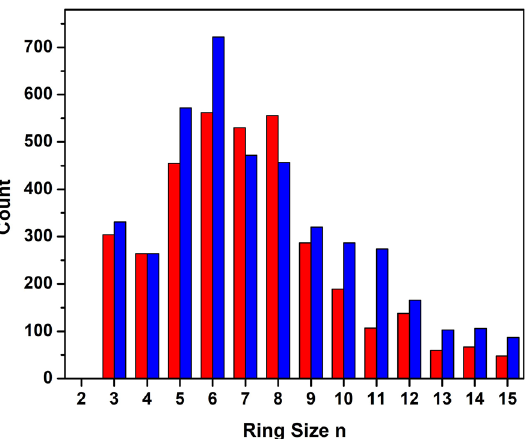
Figure 5. The number of King’s rings as a function of the number of nodes obtained from the MD simulations of the hydrous albite melt (blue) and dry albite melt